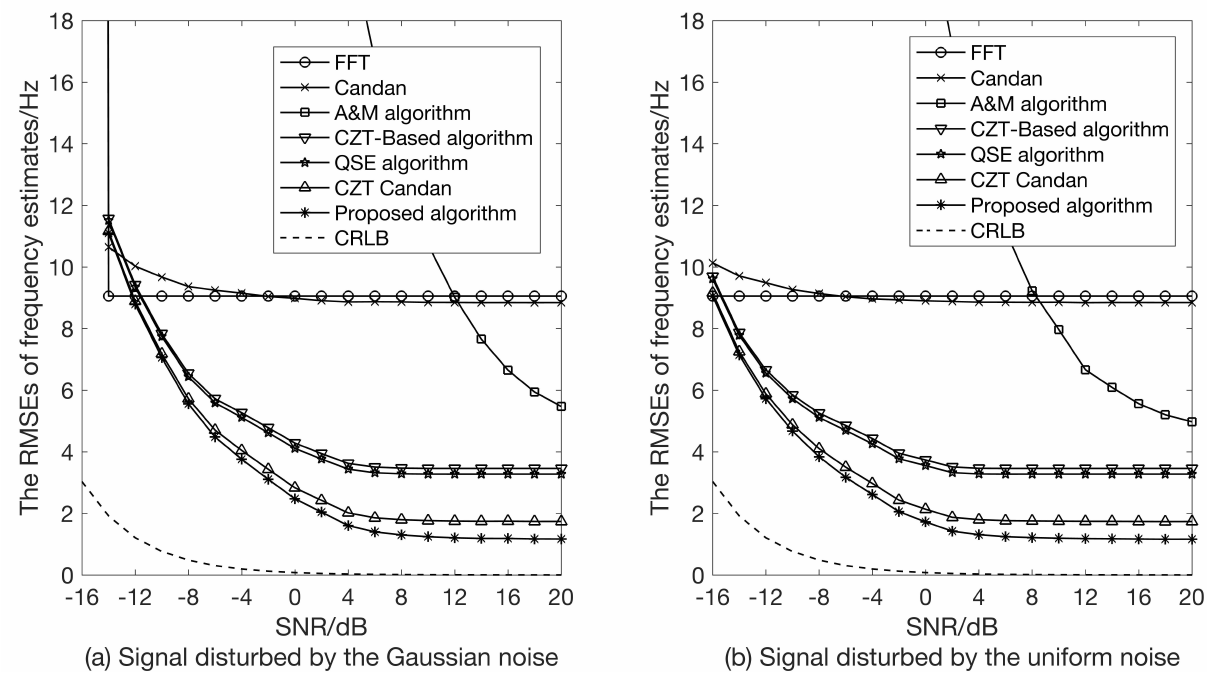
Figure 3. The RMSEs of frequency estimates of various algorithms versus